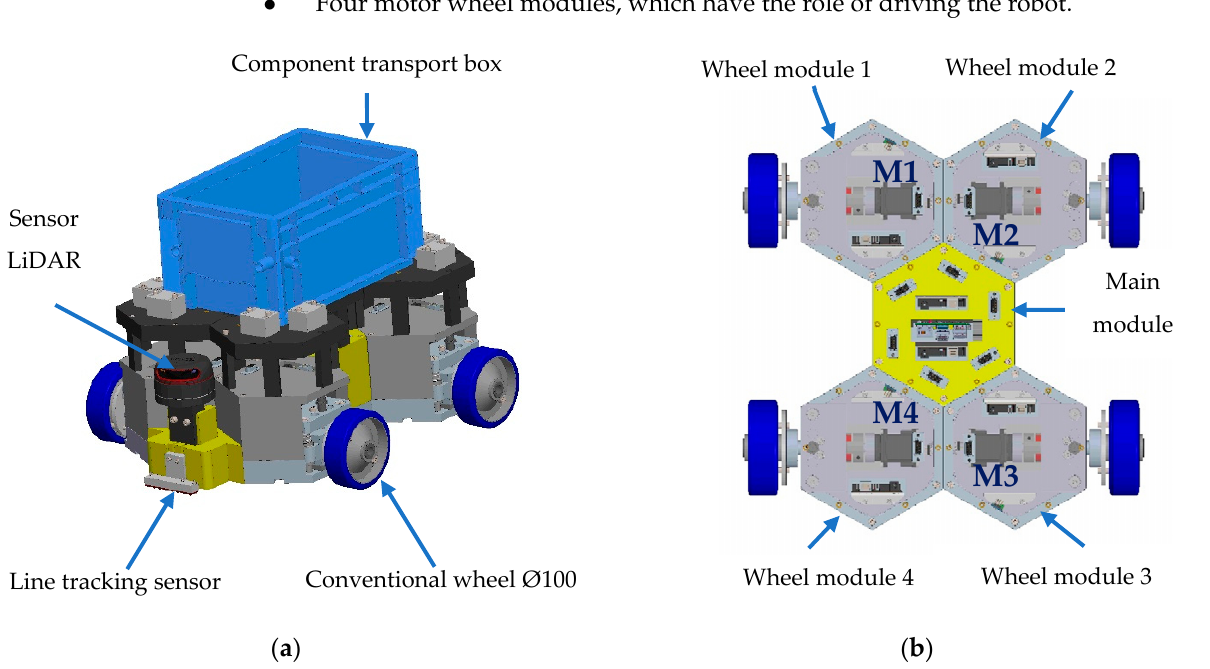
Figure 2. Modular mobile robot with four conventional wheels (3D model). ( a ) Isometric view. ( b ) Bo tt om view. Table 2. Technical characteristics of the conventional two-wheeled modular mobile robot. Size